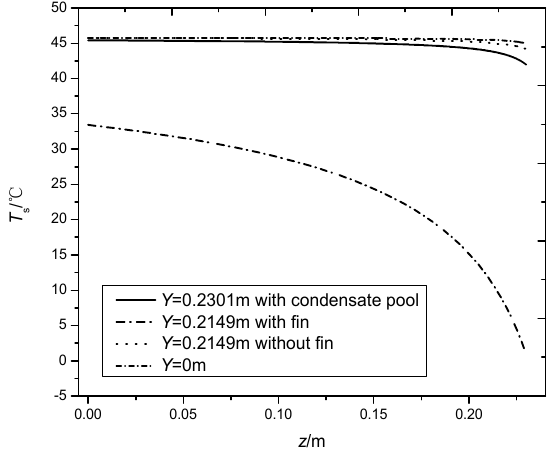
Figure 7. Four representative condensation temperatures for finned flat tube.